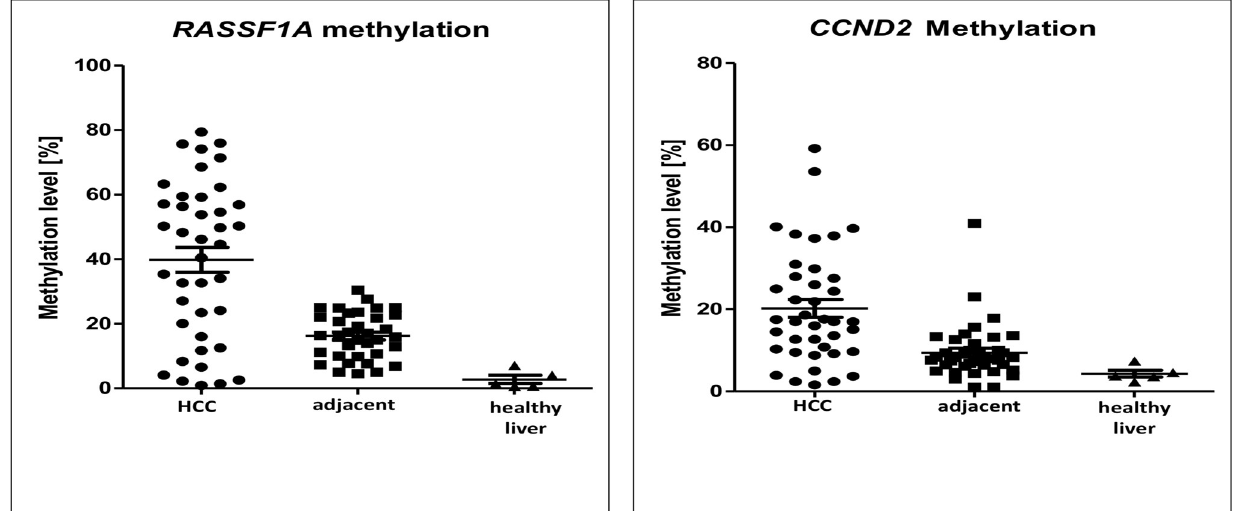
Fig 3. RASSF1A and CCND2 DNA methylation levels in HCC, adjacent peritumoral tissues, and healthy liver. DNA methylation levels were significantly higher in HCC compared to pertitumoral tissues both for RASSF1A (mean methylation levels were 39.8 and 16.2, p < 0.0001, respectively) and CCND2 (mean methylation levels were 20.2 and 9.4, p < 0.0001, respectively). For DNA methylation levels of individual CpG sites see S4 Table.